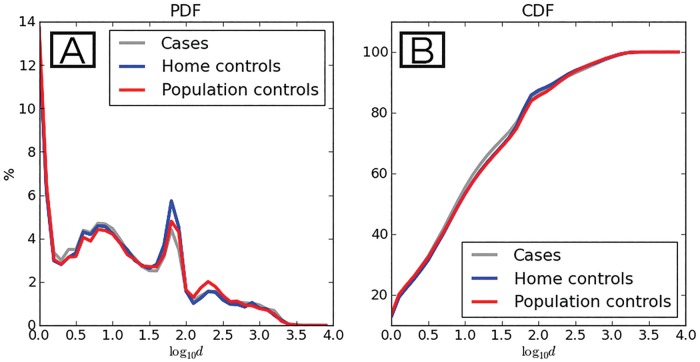
Distribution of the absolute displacement variable for each study group.(A) Probability distribution function (PDF). (B): Cumulative distribution function (CDF). Y axis: Percentage of waypoints recorded, X axis: Distance from home centroid. Distance in meters is expressed on a logarithmic scale. Line colors: gray depicts data of cases, blue depicts home (intradomestic) controls, and red depicts population controls.